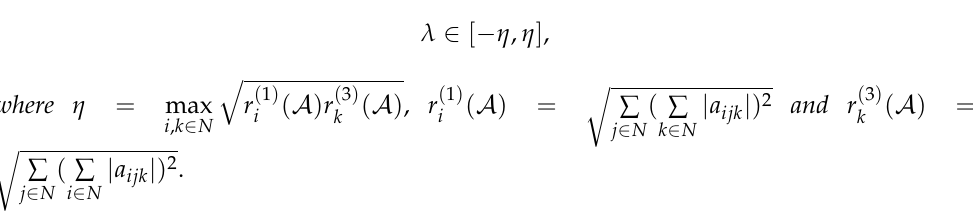
Figure 1. Comparisons among ρ and ρ Q in [12] and δ and δ Q for A KBi = 1 and Cauchy–Schwartz inequality, we are in the position to establish the y 2 By ∑ j j ∈ N following